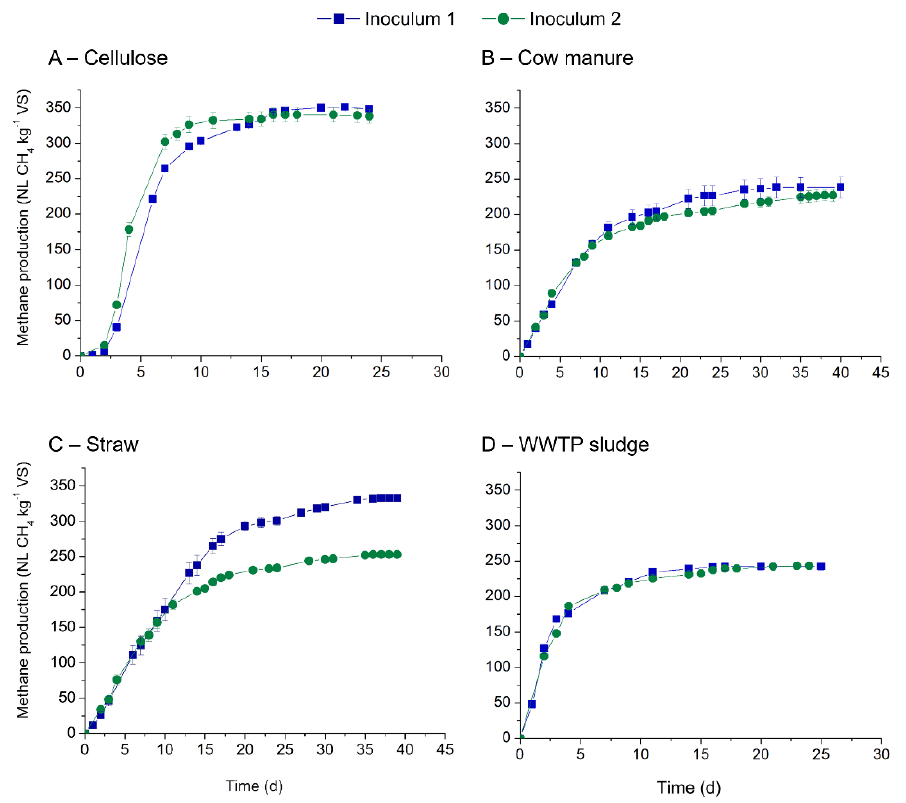
Figure 2. Methane production obtained for two inoculum using four substrates: ( A ) cellulose, ( B ) cow manure, ( C ) straw and ( D ) WWTP sludge.